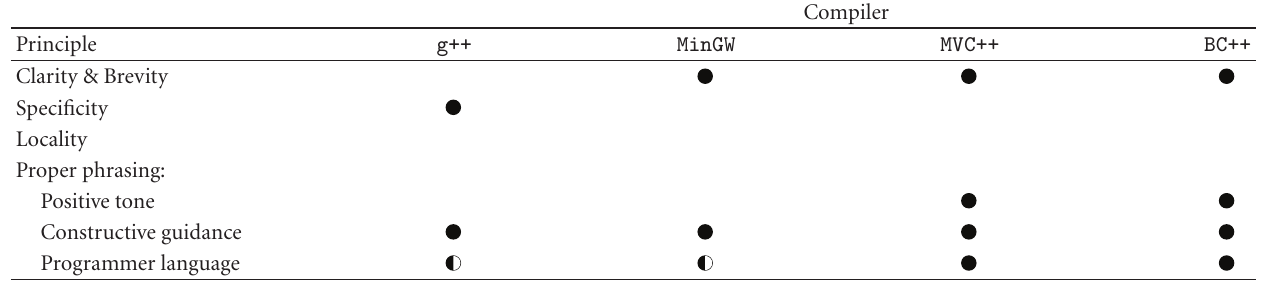
Table 11: Which principles are violated by which compilers for Error message